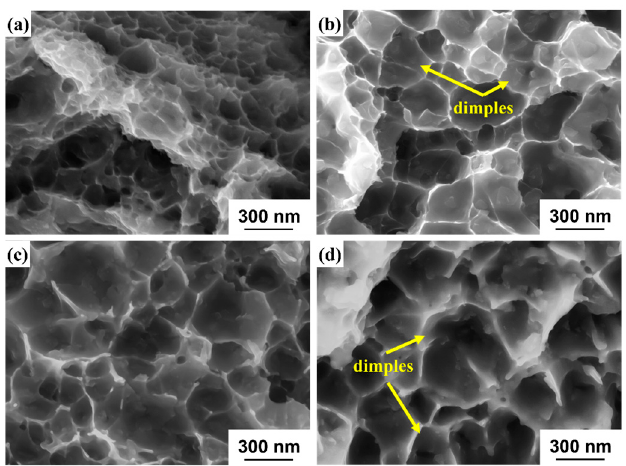
Figure 4. Fracture morphology after tensile testing for SLM-fabricated Al-12Si samples annealed at 573 K and deformed at ( a ) 300 K; ( b ) 373 K; ( c ) 423 K; and ( d ) 473 K.